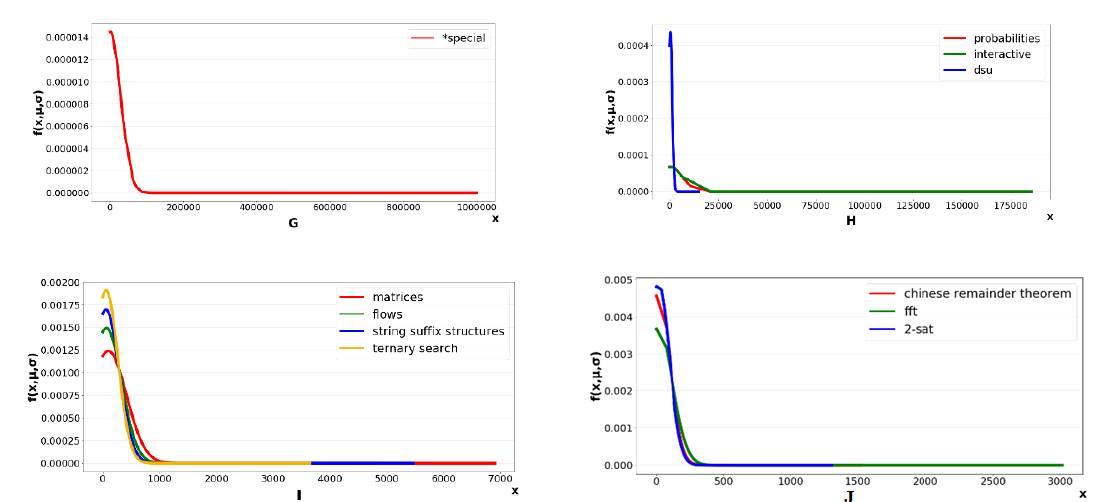
Figure 7. Probability density graphs on corresponding skills: ( A ) math, implementation, brute force, dp, greedy; ( B ) binary search, sortings, constructive algorithms, data structures, strings; ( C ) geometry, bitmasks, trees, combinatorics, two pointers; ( D ) divide and conquer, games, shortest paths, hashing; ( E ) meet-in-the-middle, graph matchings, expression parsing, schedules; ( F ) number theory, dfs and similar, graphs; ( G ) *special; ( H ) probabilities, interactive, dsu; ( I ) matrices, flows, string suffix structures, ternary search; ( J ) Chinese remainder theorem, fft, 2-sat.